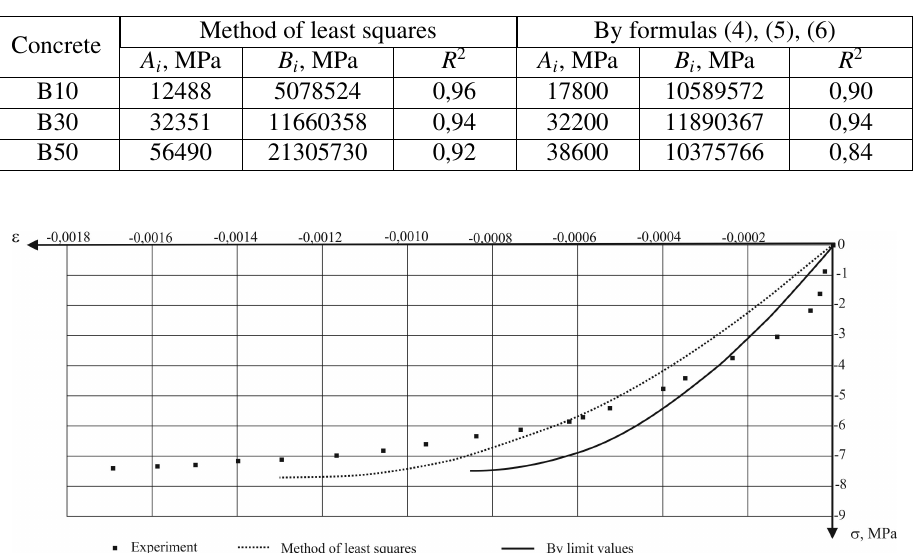
Figure 3. A compression diagram of concrete grade